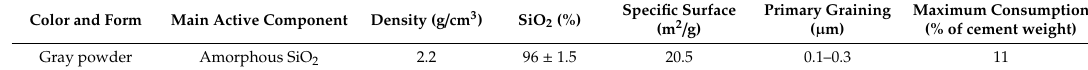
Table 2. Physical and chemical properties of silica fume.